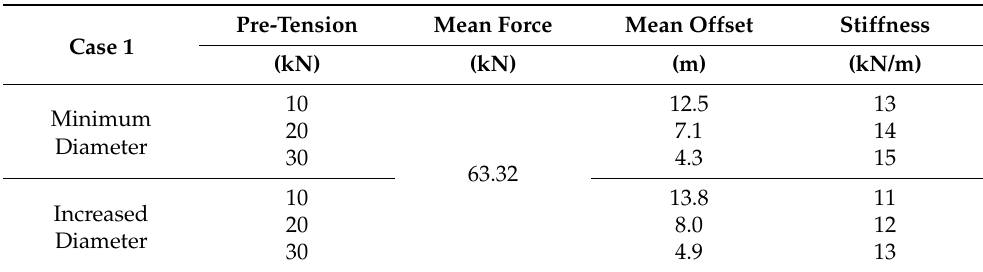
Table 7. Mean offset and stiffness, Case